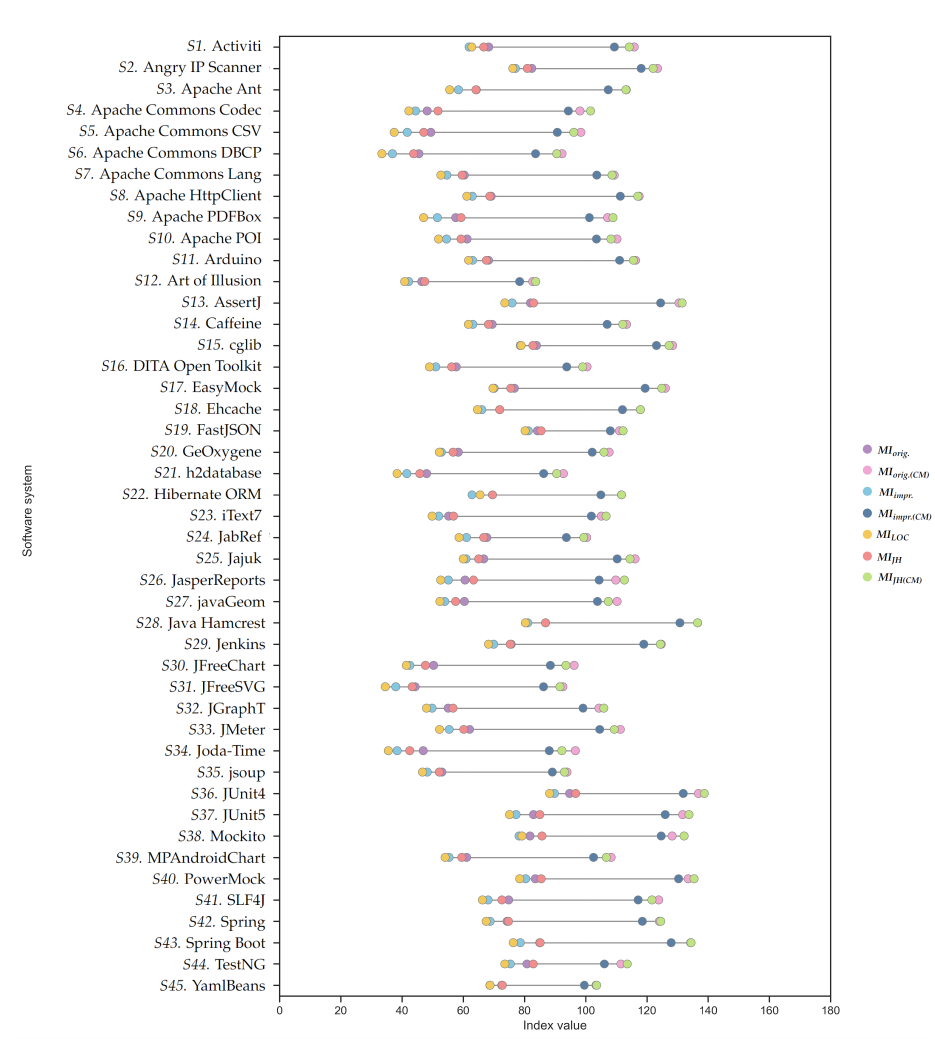
Figure 2. Dot plot of Index variant values for each subject software system. Table 9. Descriptive statistics and normality test of Index variant